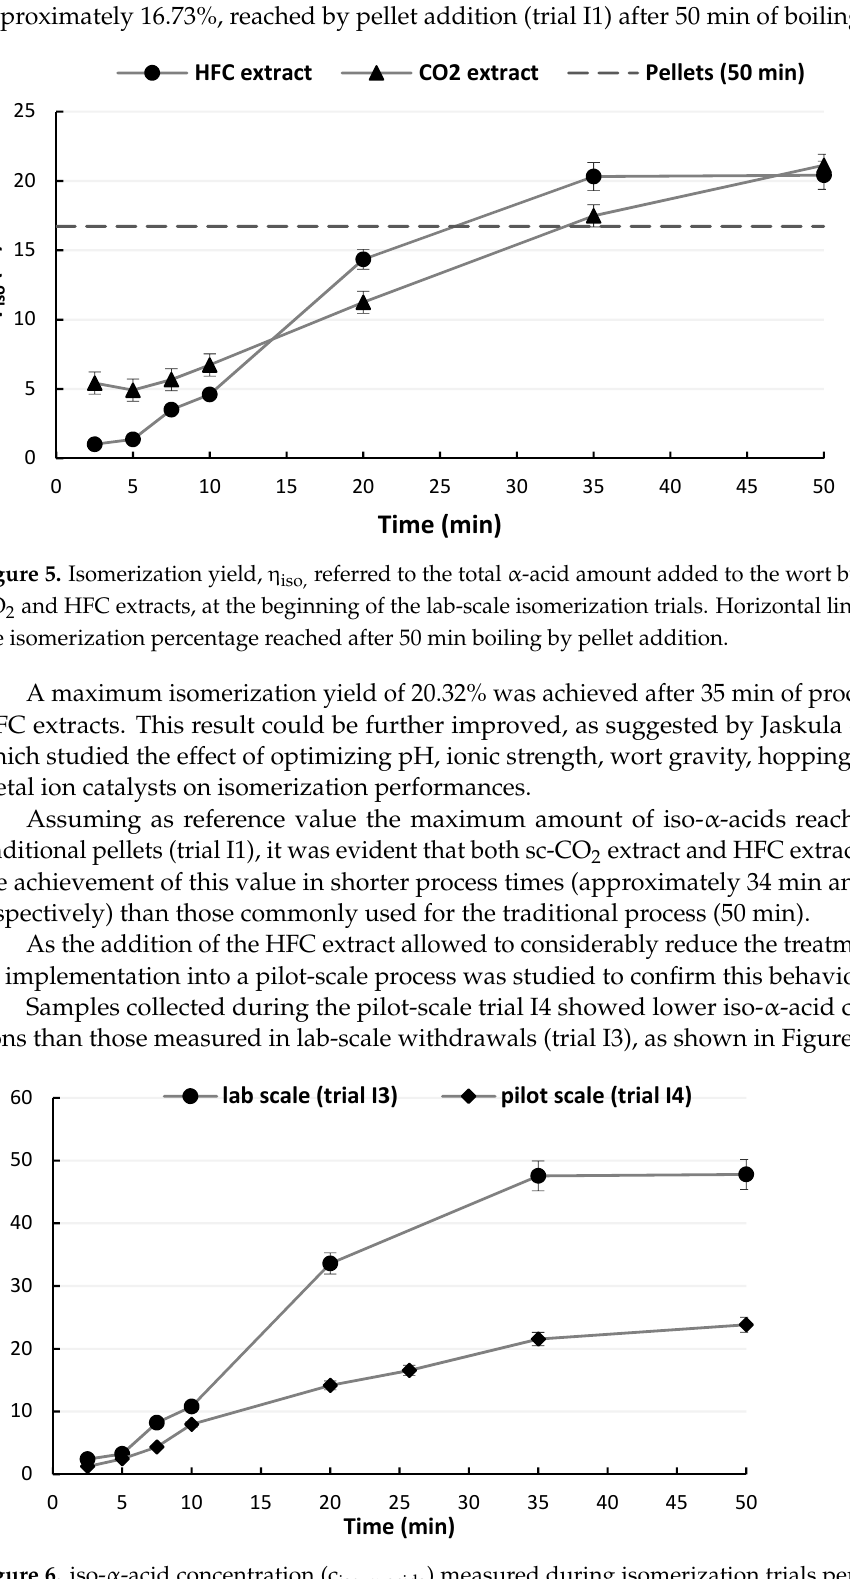
Figure 6. iso- α -acid concentration (c iso- α -acids ) measured during isomerization trials performed at laboratory- (I3) and pilot-scale (I4) using HFC hop extracts.